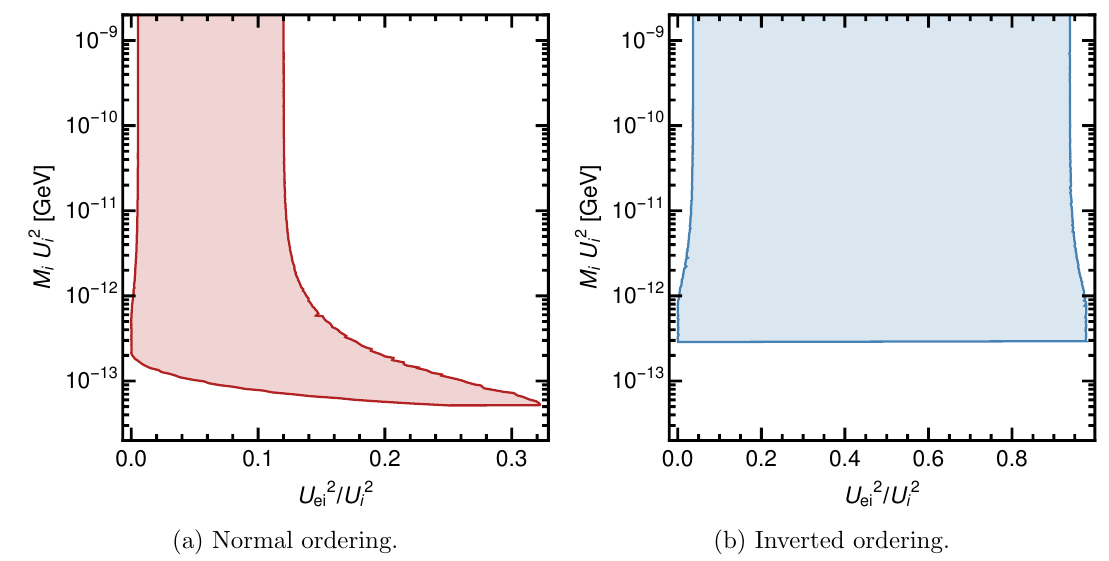
(b) Inverted ordering. Figure 2. The applicability of the symmetric limit can be illustrated by plotting the allowed range of U 2 =U 2 for di(cid:11)erent values of U 2 M i , which is in good approximation independent of M i . For ei i i both, normal ordering shown in Panel (a) and inverted ordering shown in Panel (b), the allowed range of U 2 =U 2 is independent of U 2 M i for values of U 2 > 10 (cid:0) 11 GeV . These regions correspond ei i i i M i to the interval predicted in the symmetric limit.